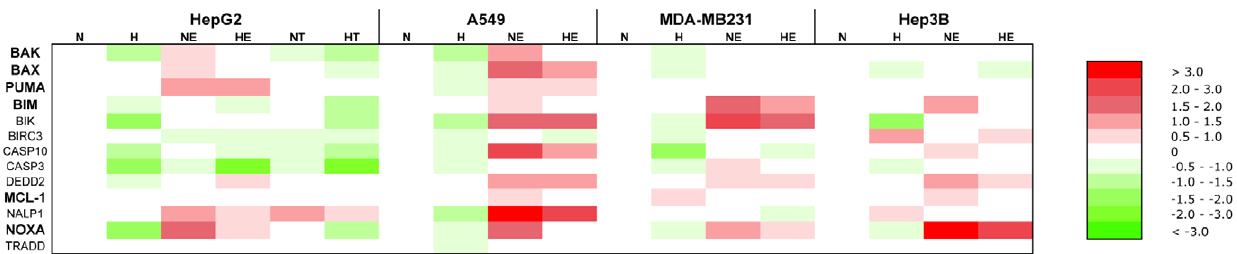
Figure 5. Effect of hypoxia, etoposide and paclitaxel on the mRNA expression level of genes involved in the apoptotic pathway. HepG2, A549, MDA-MB231 and Hep3B cells were incubated 16 hours under normoxia (N, 21% O 2 ) or hypoxia (H, 1% O 2 ) in the presence or not of etoposide (E, 100 m M in Hep3B cells and 50 m M in the other cell types) or paclitaxel (T, 10 m M) in HepG2 cells. After incubation, total RNA was extracted, submitted to reverse transcription and then to real-time PCR in the presence of SYBR Green and specific primers. Actual numerical values are provided in Table S3. Genes shown in bold are genes whose expression was assessed at the protein level by western blot analyses.